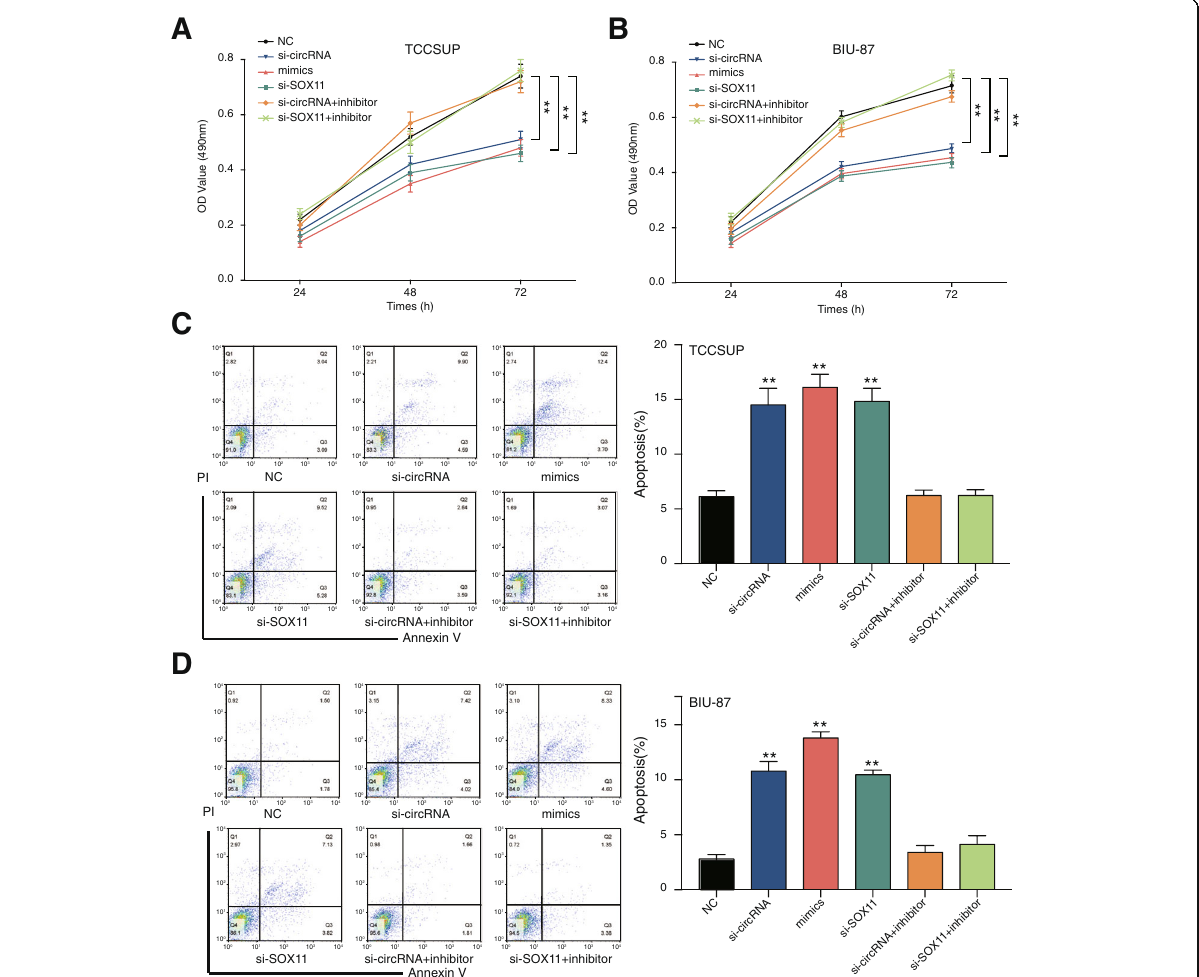
Fig. 6 Effects of circCEP128 on cell proliferation. MTT assay was also performed to assess cell proliferation after transfection with si-circRNA of circCEP128, miR-145-5p mimics, si- SOX11 , co-transfection with si-circRNA and the miR-145-5p inhibitor and co-transfection with si- SOX11 and the miR-145-5p inhibitor ( a ) in TCCSUP and ( b ) in BIU-87. Knockdown of circCEP128 inhibited cell proliferation. * P < 0.05, compared with NC. Cell apoptosis was analyzed using flow cytometry ( c ) in TCCSUP and ( d ) in BIU-87 with double staining of PI and Annexin V-FITC. Knockdown of circCEP128 induced the increased cell apoptosis rate. ** P < 0.05, compared with